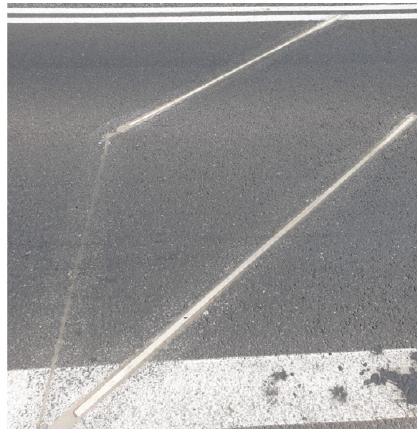
Figure 7. Piezoelectric Sensor.